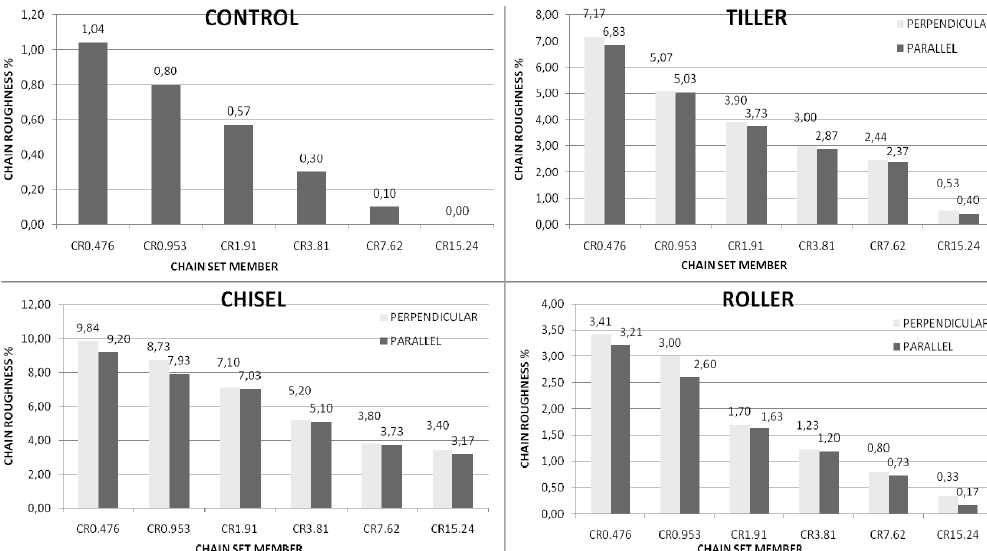
Figure 8. Fig. 8. Chain roughness after tilling with different tools and for the control. Data were measured perpendicular and parallel to tool direction. CR vs log 10 (link length)